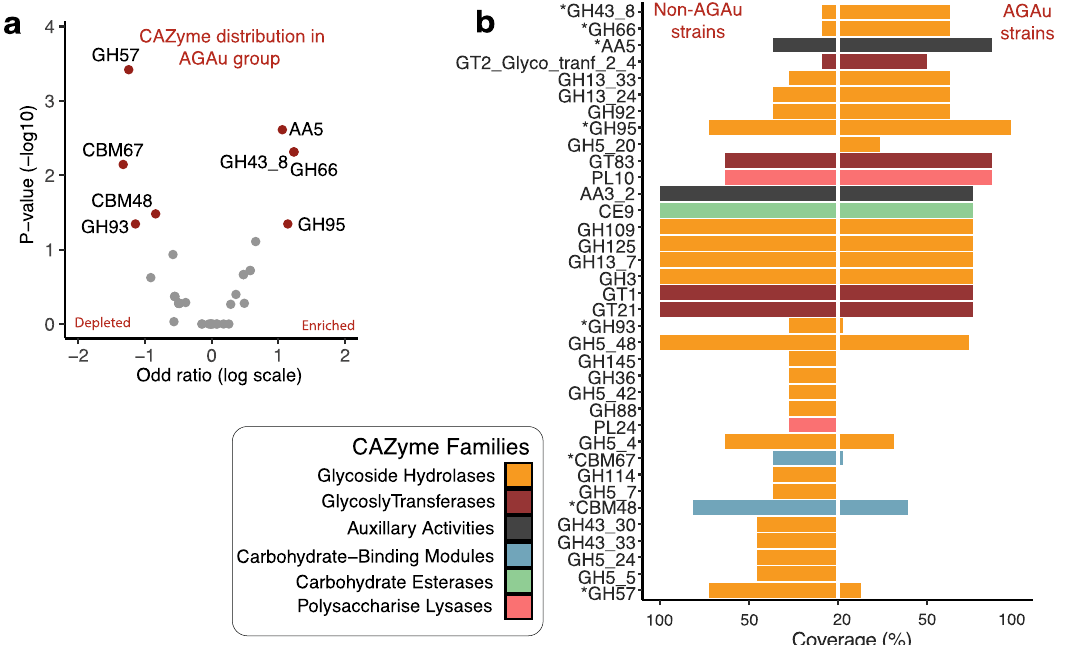
Fig. 2 CAZyme pro fi le in AGAu Candida strains. a CAZyme analysis across AGAu and non- AGAu groups . (*Asterisk connotes statistically signi fi cant CAZyme, Chi-square tests, p values < 0.05). b CAZyme enrichment and depletion in AGAu strains . Volcano plot showing statistically signi fi cant evidence of a relationship between AGAu strains (Chi-square tests, p values < 0.05 and odds ratio on enriched and depleted in AGAu strains, in